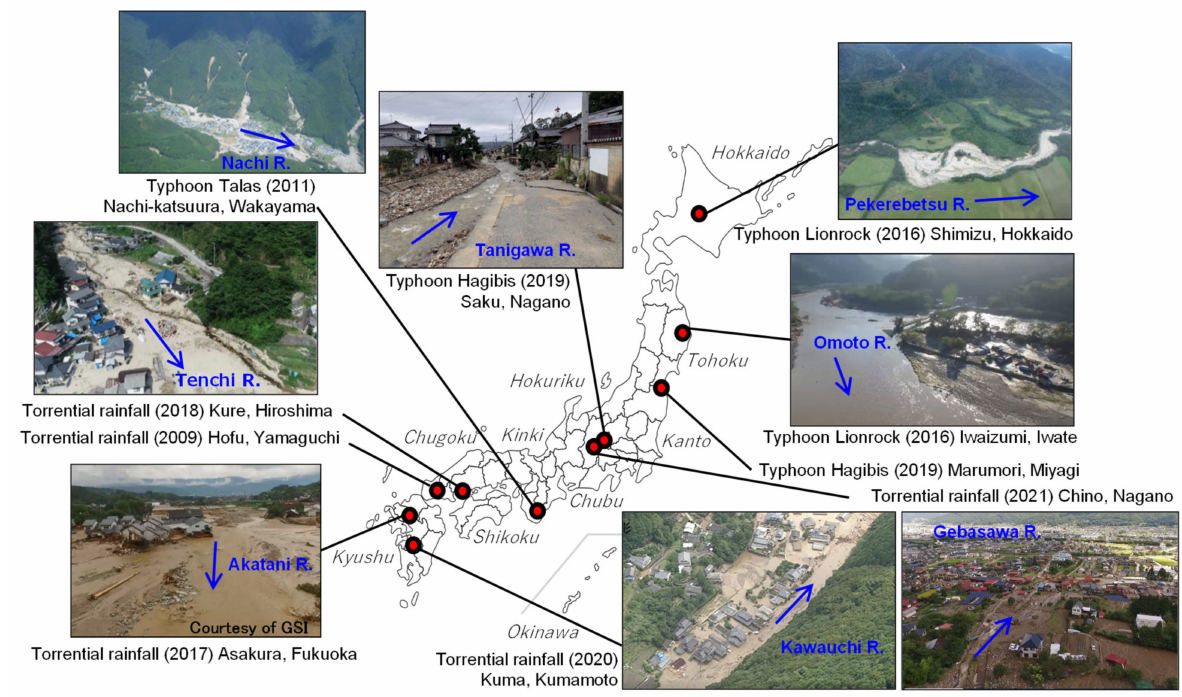
Figure 4. Distribution of recent sediment-laden floods in Japan since